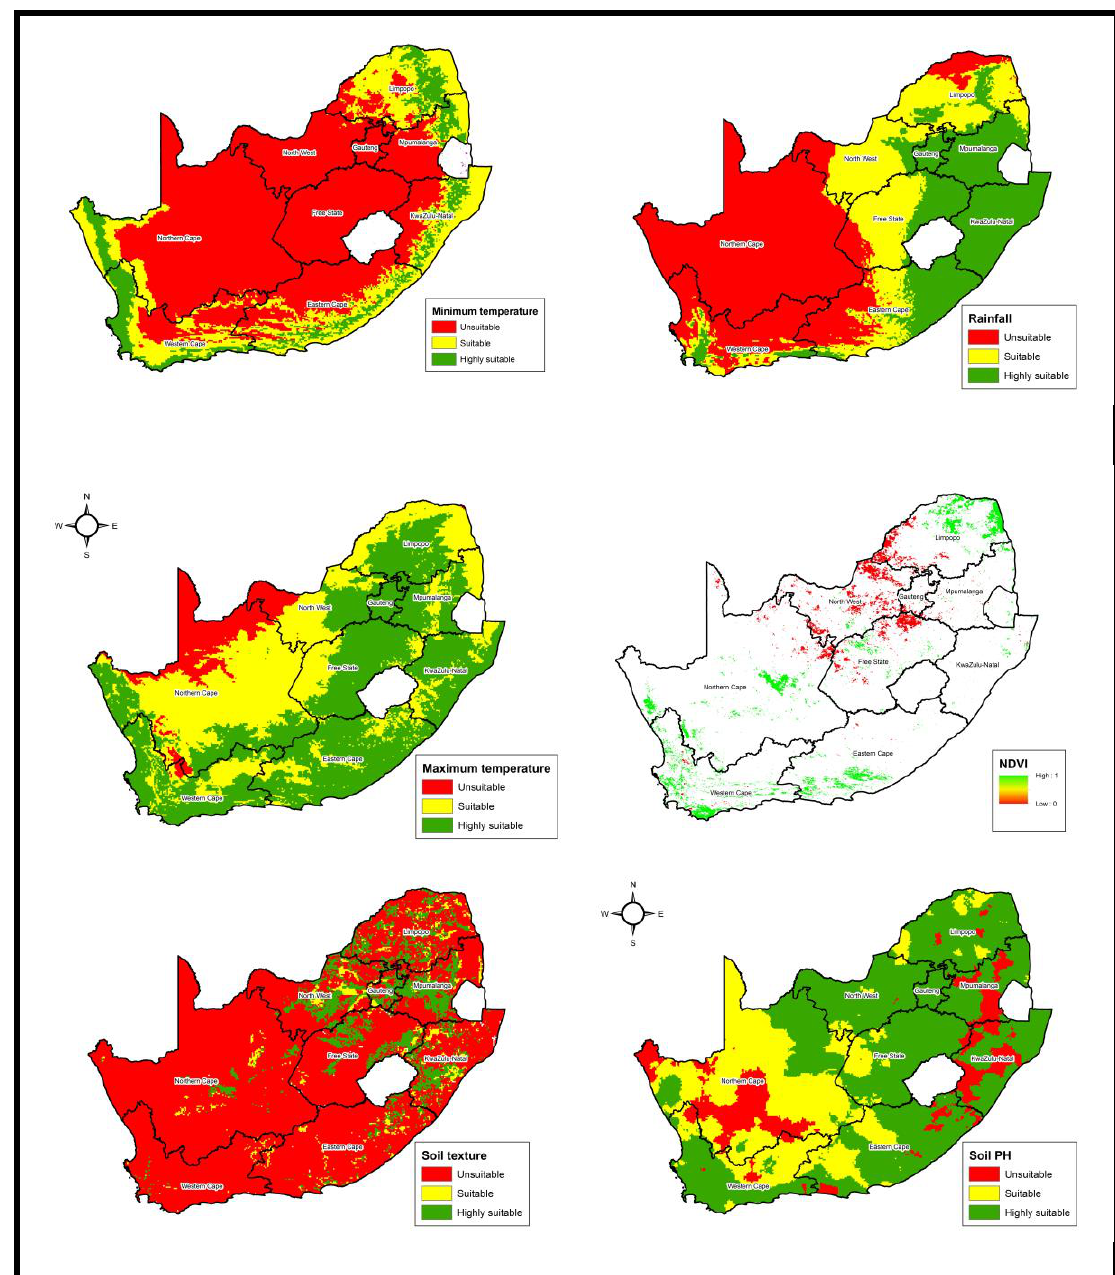
Figure 4: Selected criterion for agricultural suitability for South